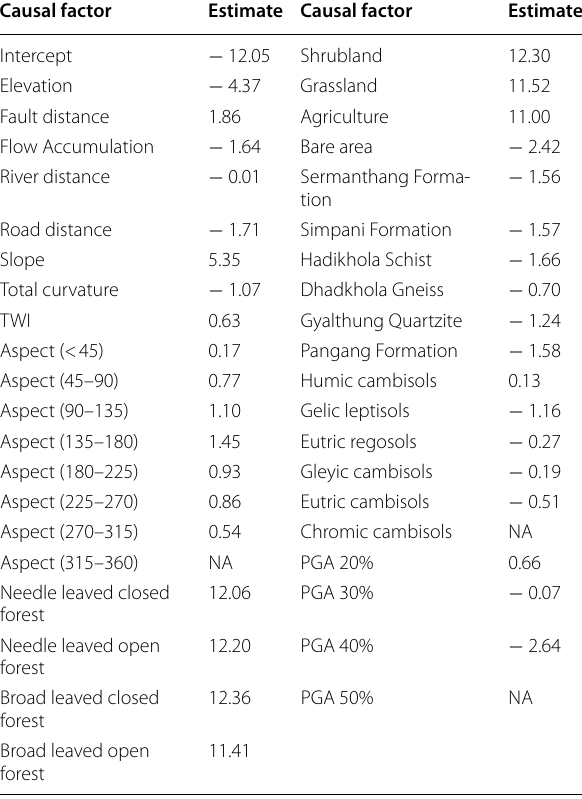
Table 2 Logistic regression (LR) coefficients of landslide causal factors indicating the relative significance for landslide occurrence, and constant